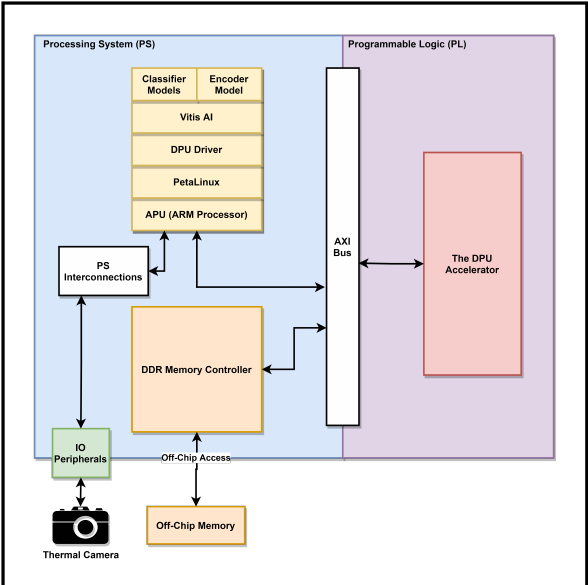
Figure 10. Proposed system block